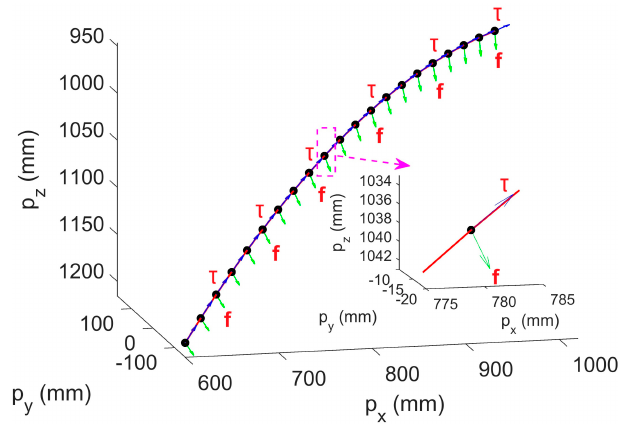
Figure 6. Example of unit tangent and normal vectors for discrete positions of target curve.